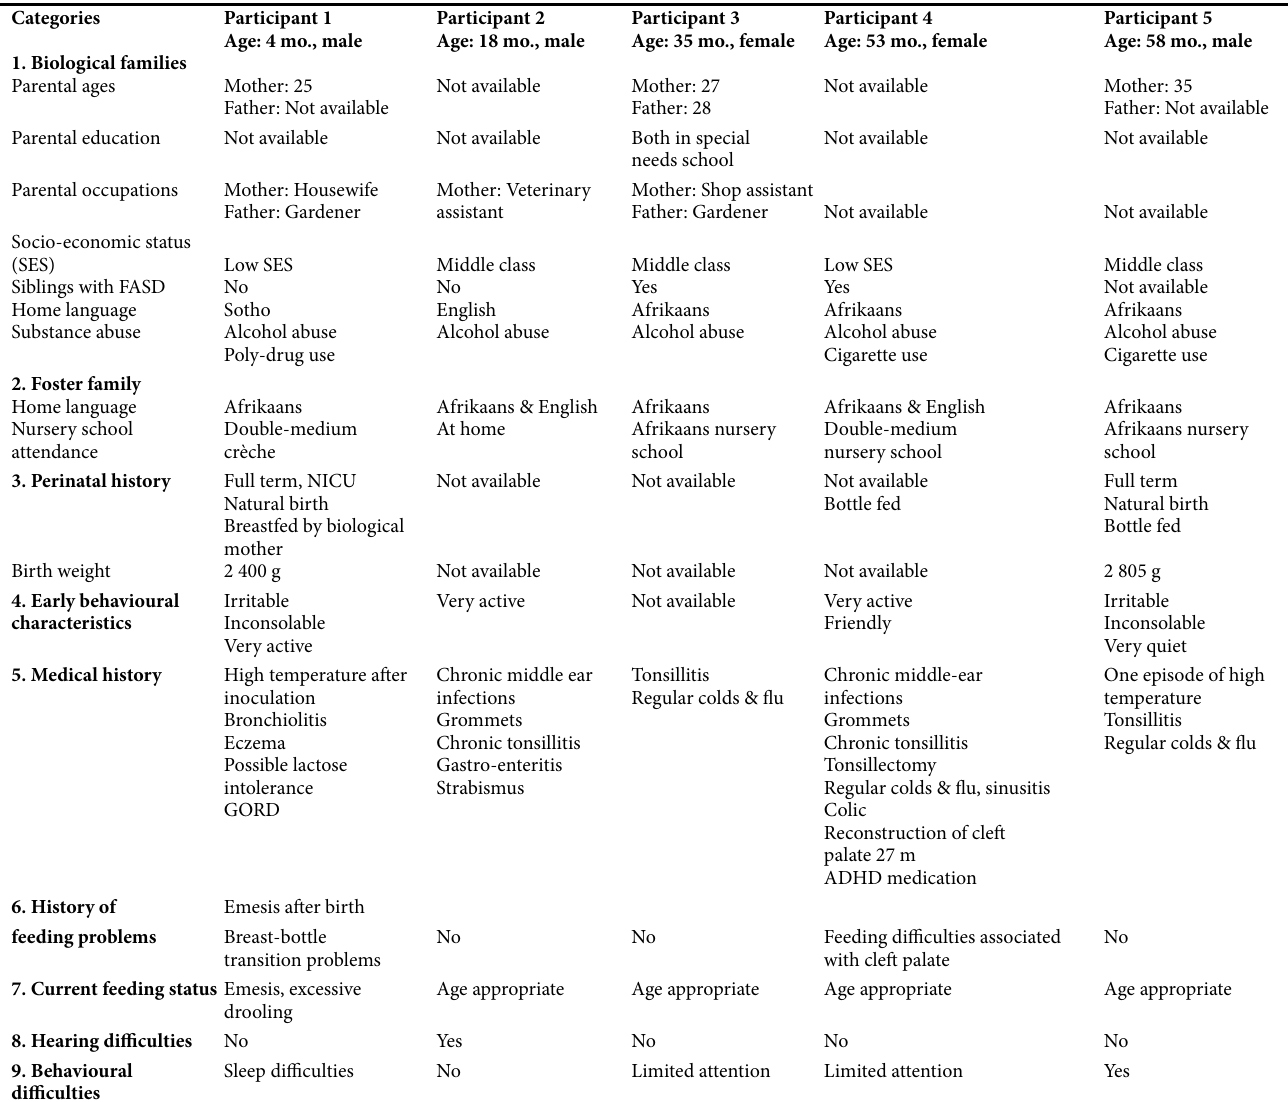
Table III. Summary of the participants’ case histories as reported by the foster and adoptive parents ( N